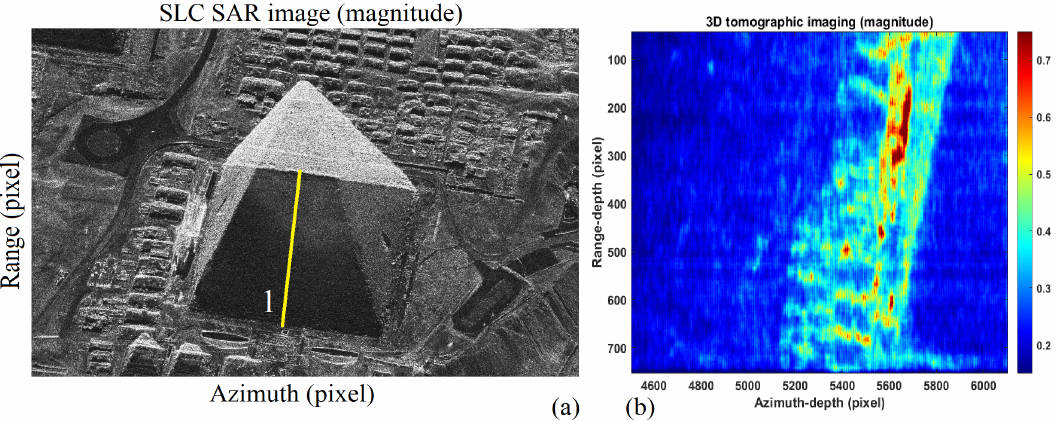
Figure 36. SAR images. ( a ): SLC SAR image (magnitude). The tomographic line 1 is oriented along the Eastern-side of the pyramid. ( b ): Tomographic result (magnitude).